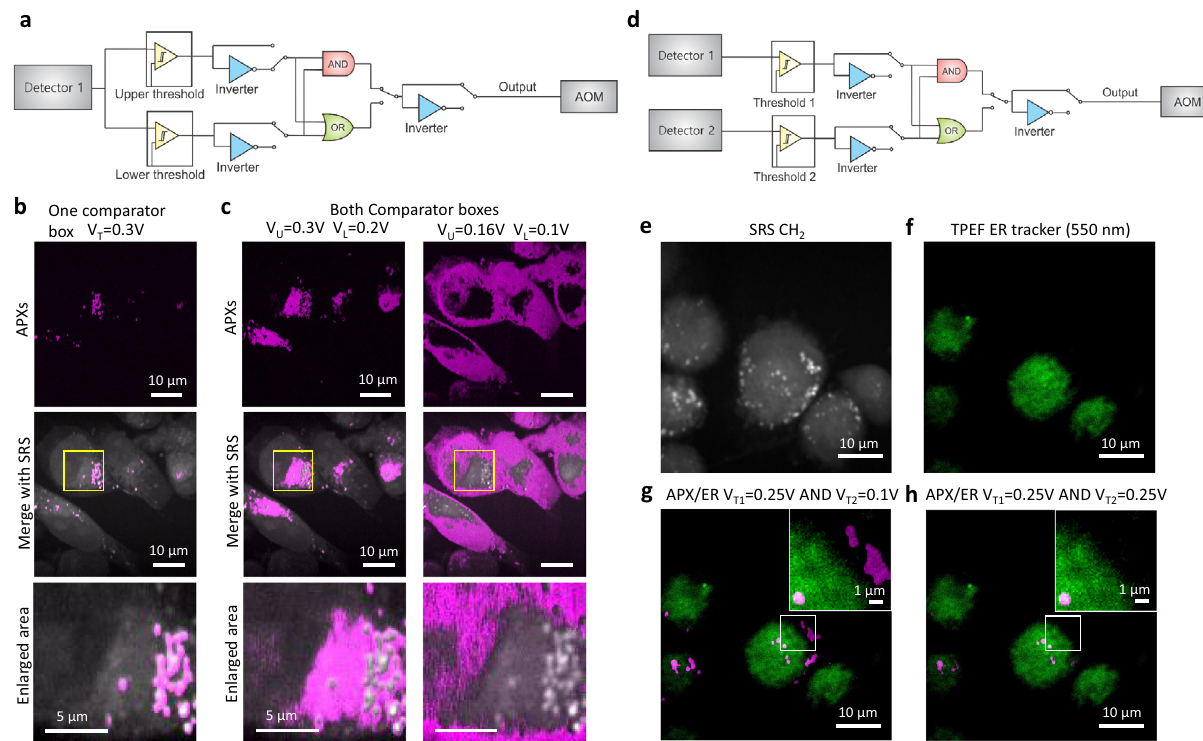
Fig.3|Digitallogiccontrolofactivepixels(APXs).a Anillustrationofelectronics to selectan intensitypassband for the determinationof APXs. b The APXs selected using only one comparator box with V T =0.3V (upper panel), the overlay of the APXswiththecorrespondingSRSimagefromthesame fi eldofview(middlepanel), andamagni fi edimagefromtheselectedarea(bottompanel). c APXsselectedusing twocomparatorboxeswiththeintensityrangebetween0.2 – 0.3V(leftpanels)and 0.1 – 0.16V (right panels). d Illustration of electronics to choose the AND function